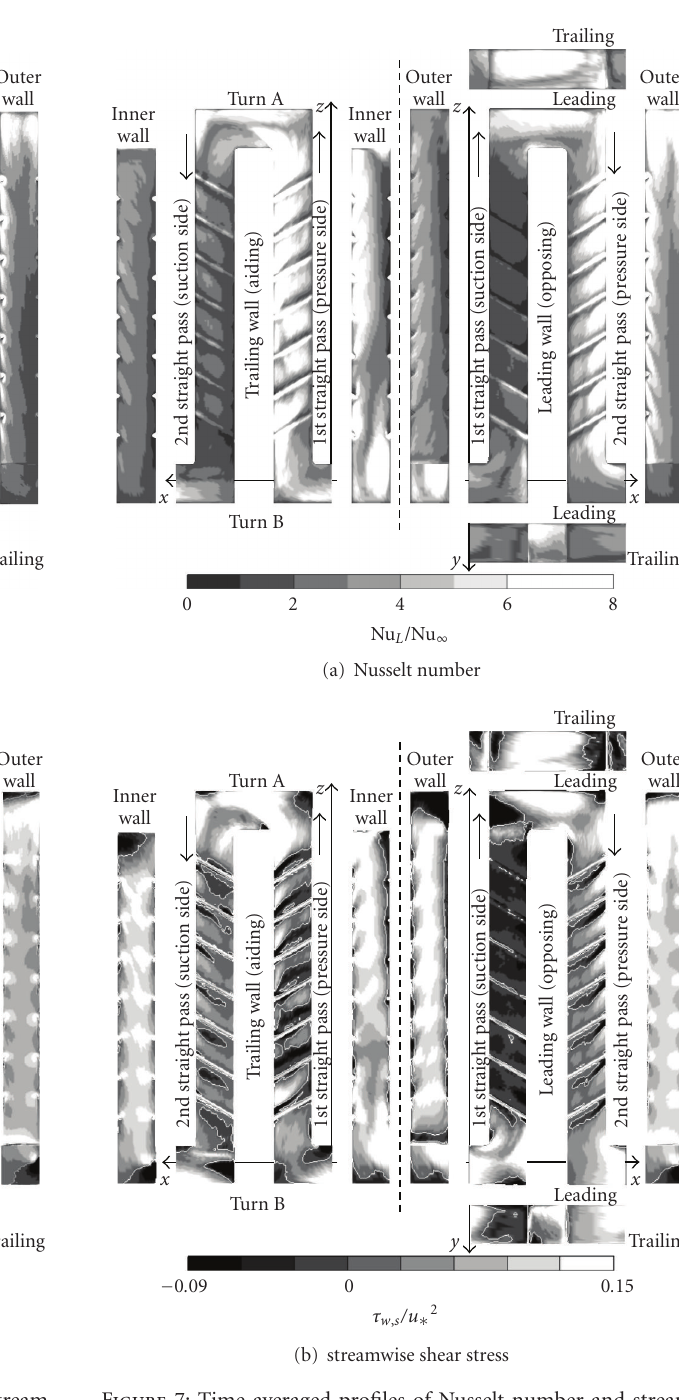
Figure 6: Time-averaged profiles of Nusselt number and stream- wise component of wall shear stress (60 ◦ rib NP, Re ∗ = 3000, Ro ∗ = 1, and Ra ∗ = 1 × 10 5 ).